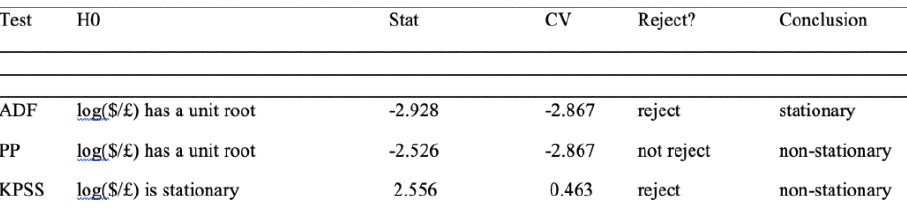
Table 2: Unit root/stationarity tests on log($/£)